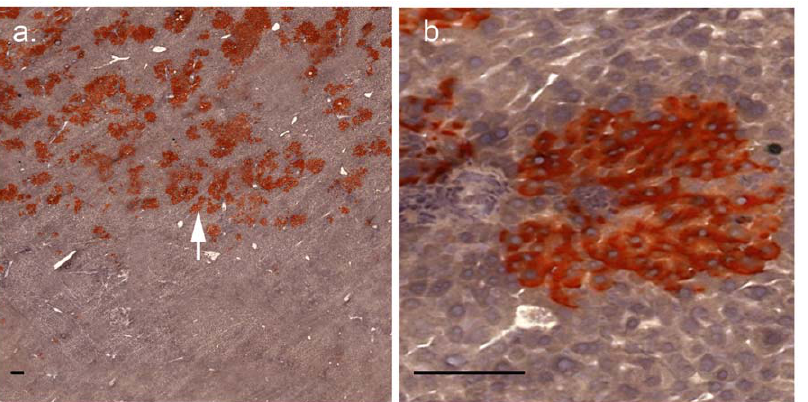
Figure 1. Regiospecific liver repopulation in DPPIV 2 recipients by donor DPPIV + hepatocytes following conformal HIR of one half of the median lobe. All liver lobes, except one half of the median lobe were shielded from HIR. Three months after hepatocyte transplantation, liver sections were stained histochemically for DPPIV activity. A region at the junction of the irradiated and non-irradiated regions of the median lobe is shown. Panel a. Low power view showing clusters of DPPIV-positive donor hepatocytes (red, white arrow) in the upper part of the section that had received preparative HIR, and the absence of such clusters in the lower part of the section that had been shielded from HIR. Panel b. High power view showing a donor hepatocyte cluster. The black bars indicate 100 m m.